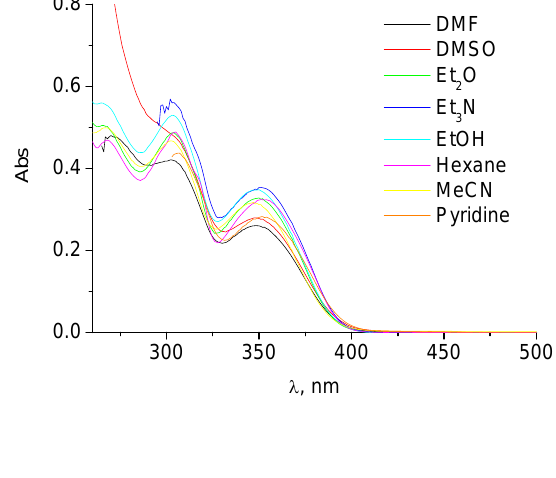
Figure 3. Absorption spectra of 1 in different solvents (concentration ca. 3 × 10 -5